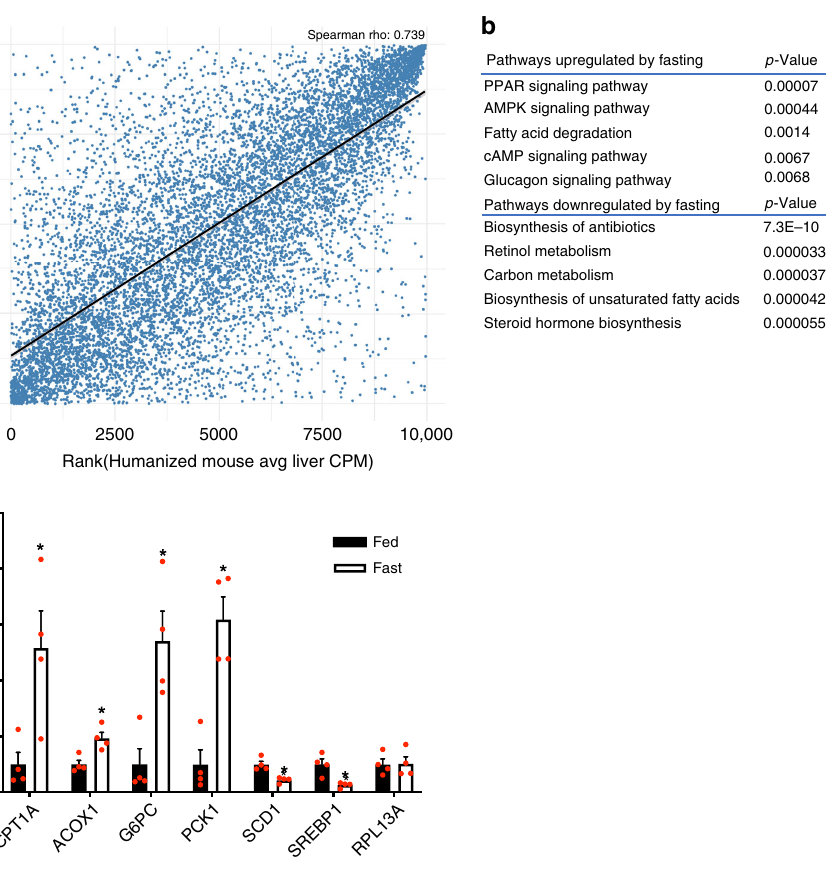
Fig. 2 In vivo regulation of human hepatic genes in a humanized mouse model. a Spearman correlation analysis of RNA-seq data from human liver tissue and humanized liver. The blue dots represent all human genes expressed in the liver. b Representative pathways overrepresented by human protein-coding genes regulated by fasting in humanized liver. c Expression levels of representative genes of major metabolic pathway in the livers of humanized mice fed ad libitum (Fed, n = 4), subject to a 24-h fast (Fast, n = 4). Data in ( c ) represent mean ± SEM, * p < 0.05, two-tailed unpaired Student ’ s t -test. Source data of ( c ) are provided in the Source Data fi